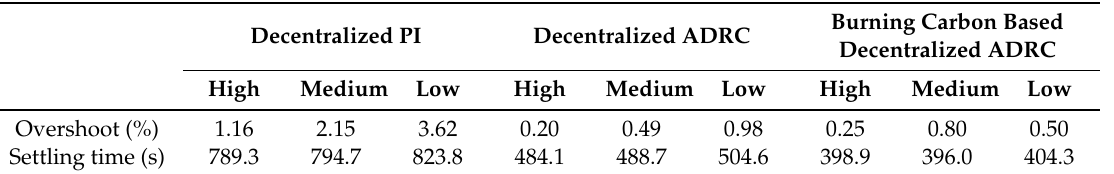
Table 3. Transient response criteria of throttle steam pressure for the supercritical CFB unit at typical conditions (load